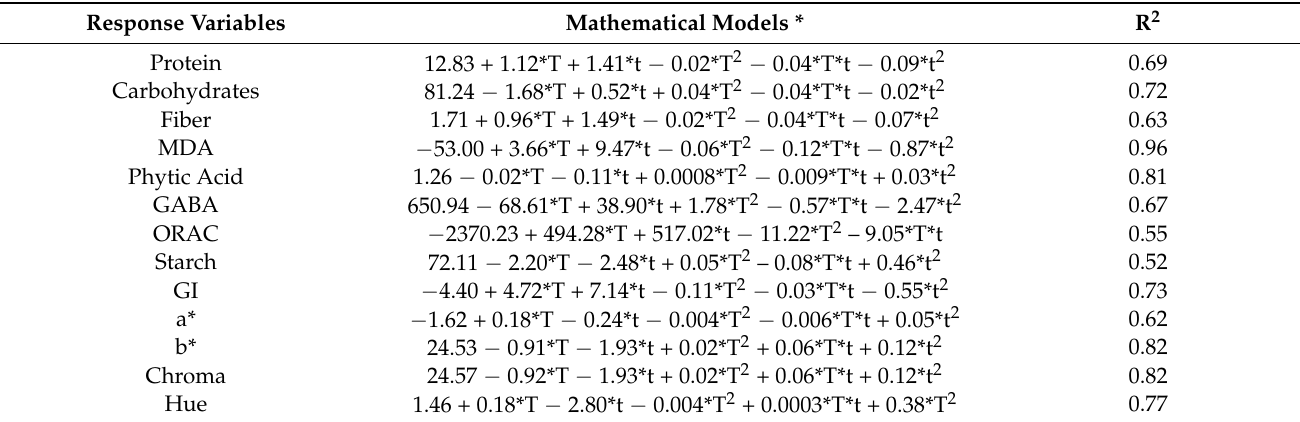
Table 2. Predicted mathematical models and regression coefficients for the response variables studied in sprouted lentil flours as a function of germination temperature (T) and time (t). Response variables with R 2 higher than 0.5 were included in the table.